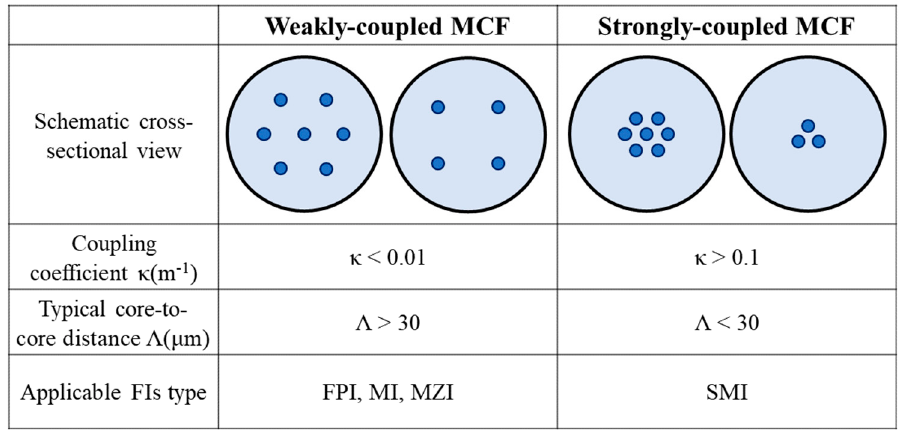
Figure 2. Classification of MCF for interferometers [9].